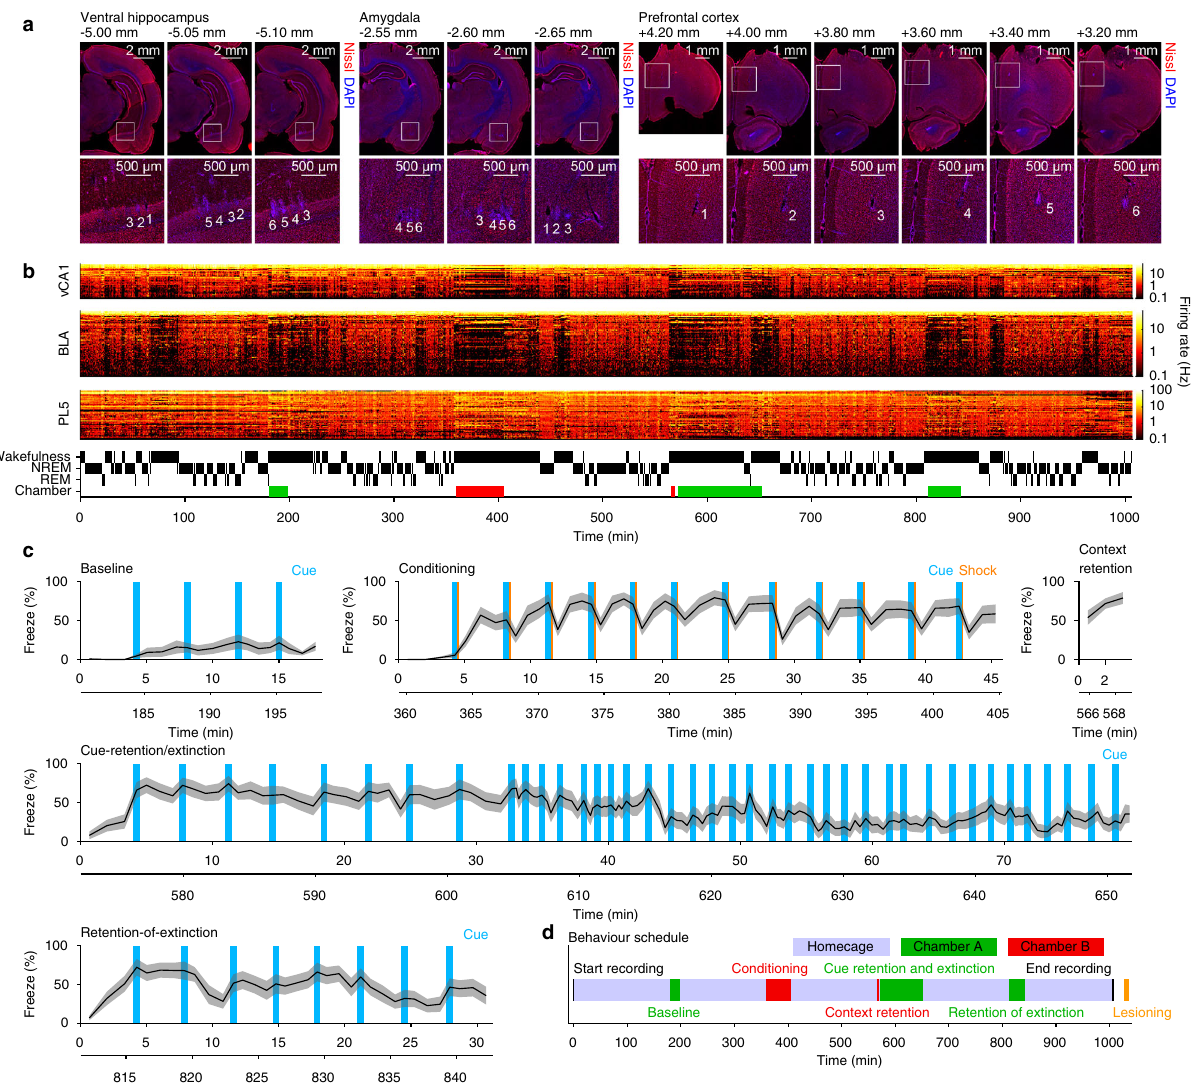
Fig. 1 Multi-regional large-scale electrophysiological recordings on fear-conditioned rats. a Electrode tip locations in a representative rat. The areas indicated by white squares in the top panels are shown in the bottom panels at higher magni fi cation. The numbers indicate the shank indices within each probe. The A – P axis coordinate from the bregma is shown at the top-left corner of each micrograph. b Unit activity and hypnogram from the same rat. Each row represents the fi ring rates of individual units in 10 s bins ( n = 35, 67, and 51 cells in the vCA1, BLA, and PL5, respectively). The periods of behavioural sessions in safe and shock chambers are indicated by green and red bands on the bottom of the bars, respectively. c Proportion of time spent in freezing in each behavioural session. The black lines and grey shaded areas indicate the mean and SEM, respectively ( n = 15 rats). Time from the session onset is shown on the x -axes, and time from the beginning of the recording is superimposed beneath the x -axes, corresponding to the x -axis in ( d ). Source data are provided as a Source Data fi le. d Schedule of the experiments. We performed approximately 17 h continuous recording during which the animals underwent behavioural sessions (highlighted with green and red), and immediately after the recording, the animals were anesthetised, and micro-lesions were made to mark the recording sites. Electrophysiological recording, behavioural sessions, and micro-lesions were performed on the same day. The black vertical lines indicate the start and end times of the recordings. Neuronal activities obtained from context-retention sessions, retention-of-extinction sessions, and the homecage sessions fl anking retention-of-extinction sessions were not analysed in this study, unless otherwise